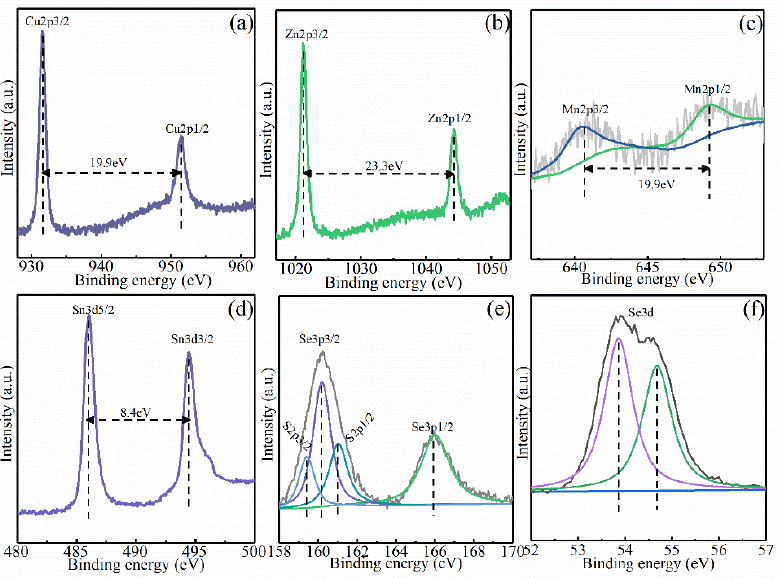
Figure 6. XPS spectra of CMZTSSe films annealed at 540 °C: ( a ) Cu 2p, ( b ) Zn 2p, ( c ) Mn 2p, ( d ) Sn 3d, ( e ) S2p, and ( f ) Se 3d.